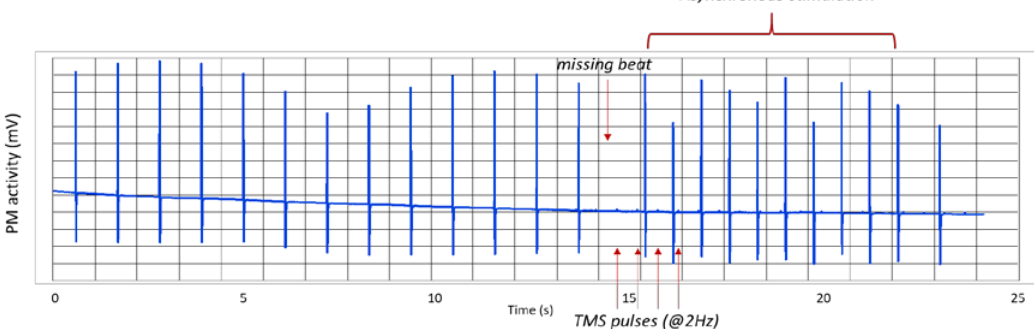
Figure 6. Example of PM activity recorded during the activation of the TMS (from t ≅ 14 s to t ≅ 24 s), with the transmitting coil parallel to the trunk of the human torso-shaped phantom and with a repetition frequency of 2 Hz.